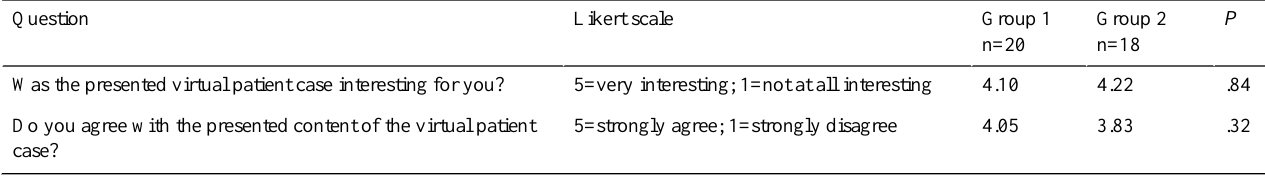
Table 5. Summary of answers in the evaluation